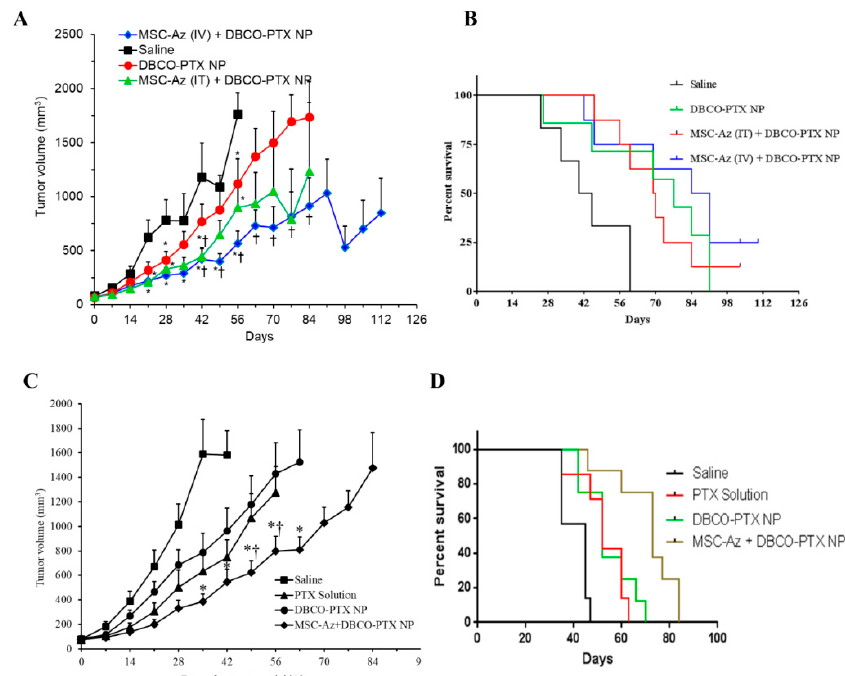
Figure 4. Antitumor efficacy of two-step targeting using glycoengineered MSCs. ( A, B ) PDX-bearing mice were intravenously injected with saline; PTX-loaded DBCO functionalized nanoparticles equivalent to 20 mg/kg of PTX (DBCO-PTX NP); 1 × 10 6 MSC-Az followed by intravenous injection of DBCO-PTX NP (equivalent to 20 mg/kg of PTX) (MSC-Az (IV) + DBCO-PTX NP) and intra-tumoral injection of 0.5 × 10 6 MSC-Az per tumor followed by intravenous injection of DBCO-PTX NP (equivalent to 20 mg/kg of PTX) (MSC-Az (IT) + DBCO-PTX NP). Mice were dosed with the respective formulation at every 14 days. ‘*’ indicates significantly different ( p < 0.05) from saline and ‘†’ indicates significantly different ( p < 0.05) from DBCO-PTX NP group. (A) Plot of tumor volume and ( B ) Kaplan – Meier survival curves for the different treatment groups. ( C, D ) PDX-bearing mice were intravenously injected with saline; PTX solution (20 mg/kg); PTX-loaded DBCO functionalized nanoparticles equivalent to 20 mg/kg of PTX (DBCO-PTX NP); and 2 × 10 6 MSC-Az followed by intravenous injection of DBCO-PTX NP (equivalent to 20 mg/kg of PTX) (MSC-Az + DBCO-PTX NP). Mice were dosed with the respective formulation at every 14 days. ‘*’ indicates significantly different ( p < 0.05) from DBCO-PTX NP group and ‘†’ indicates signi fi cantly di ff erent ( p < 0.05) from PTX solution group. ( C ) Plot of tumor volume and ( D ) Kaplan – Meier survival curves for the different treatment groups.